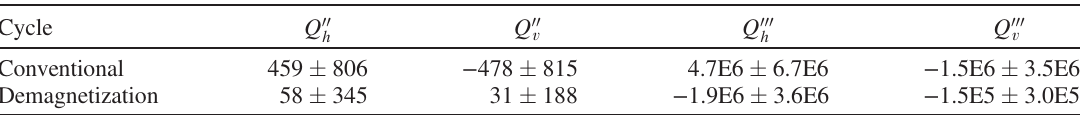
TABLE III. Comparison of the second and third order chromaticities measured with the conventional and the demagnetization